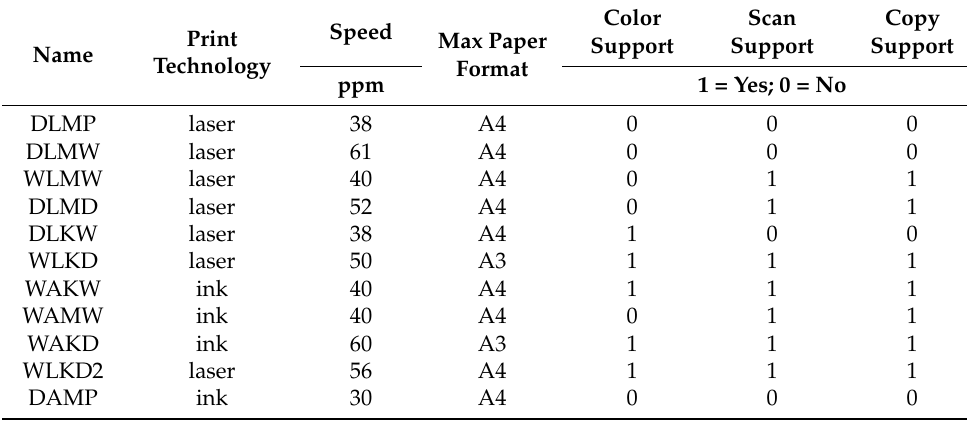
Table 3. Basic features of the printing devices used in the case